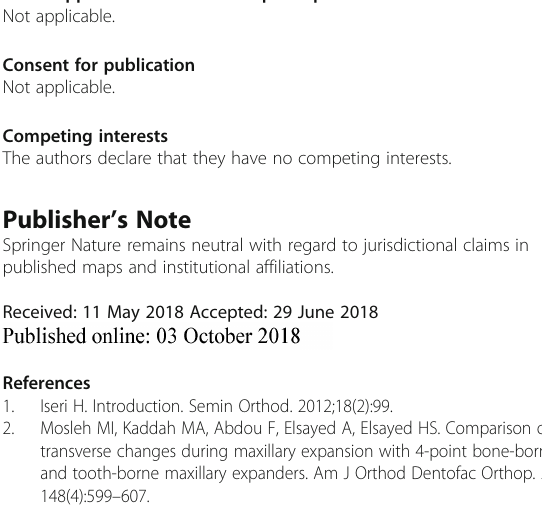
group. The differences of stress distribution both visually and statistically were found on the upper first molar re- gion of interest (ROI), palatal alveolar bone of first molar teeth, palatinal suture, and zygomatic sutures. From this, research showed the potential benefit for a clinician to use MSE in comparison to RME such as the possible al- leviation of stress distribution on the buccal bone, paral- lel split of the palatine suture, and minimized tipping of the teeth. Thus, MSE tools might be recommended for non-growing patients with possible more skeletal effects.